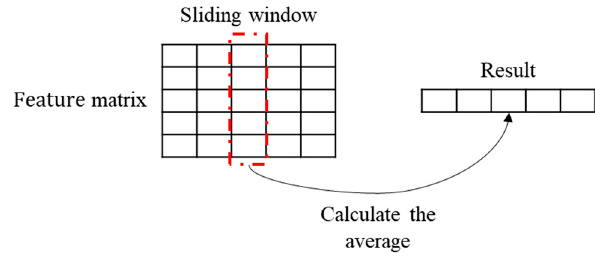
Figure 4. The operation of mean-pooling.